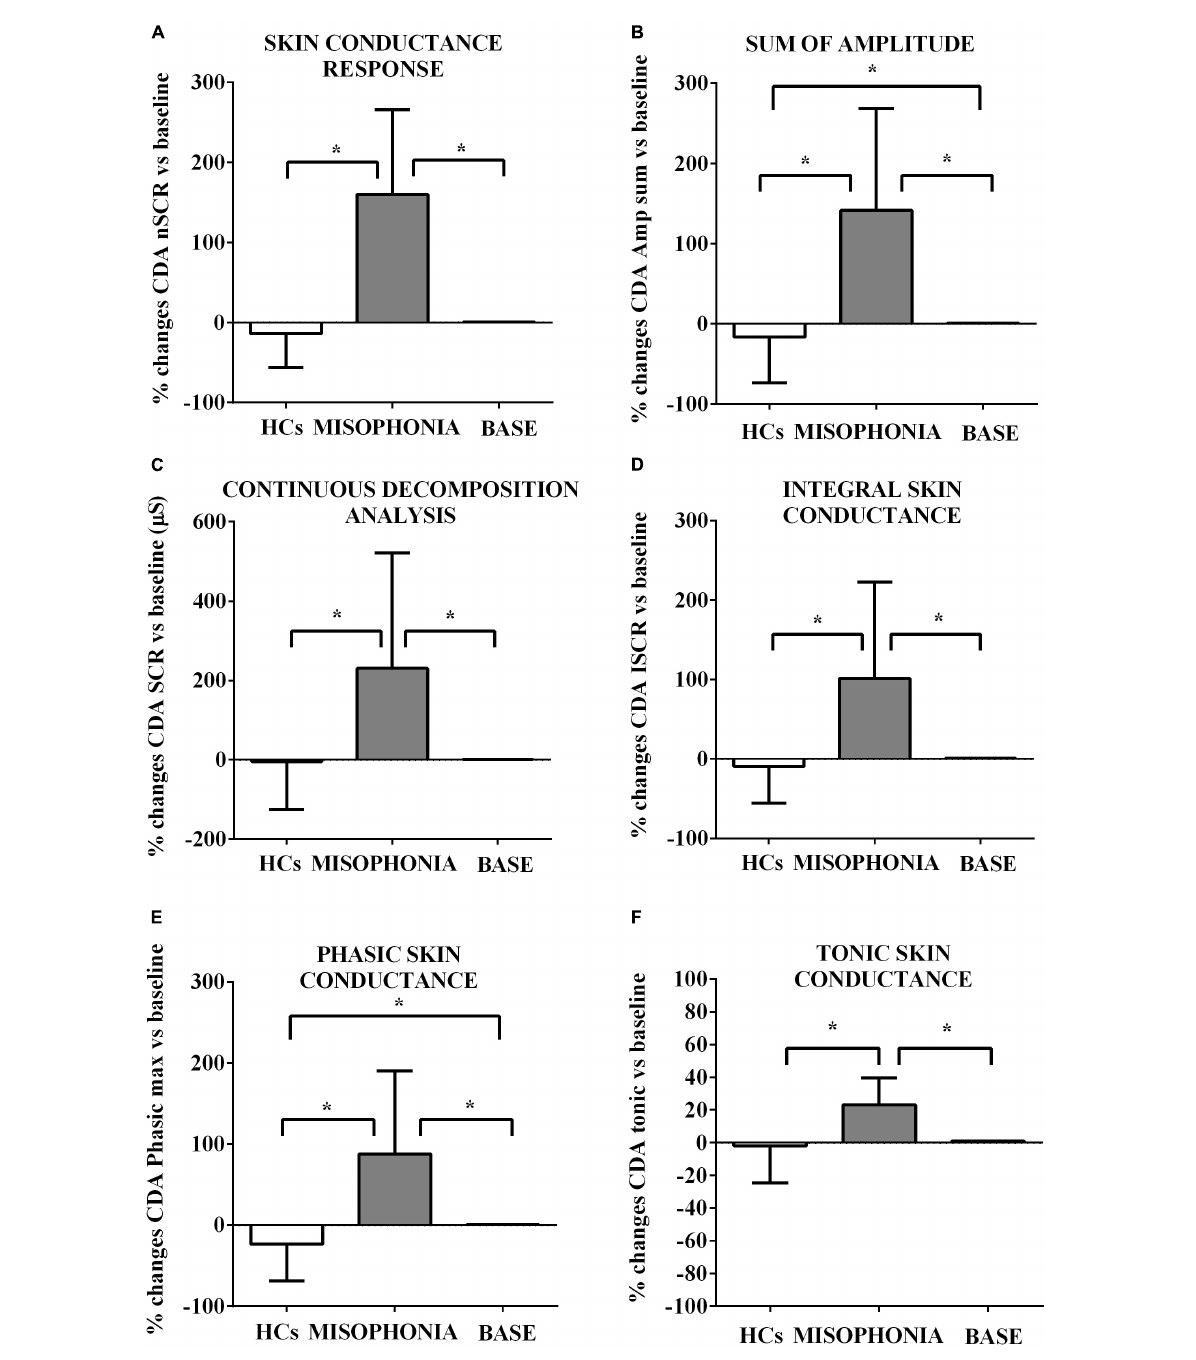
FIGURE4 Effects of the trigger sounds protocol on GSC variables in participants with misophonia and participants without misophonia [Healthy controls (HCs)] vs. specific baseline (set as 1). The results show increased orthosympathetic variables (CDA.nSCR, CDA.AmpSum, CDA.SCR, CDA.iSCR, CDA.PhasicMax, and CDA.Tonic) in participants with misophonia in comparison with values registered at the baseline (set as 1). In participants without misophonia, some of those variables related to orthosympathetic activation (CDA.AmpSum and CDA.PhasicMax) were lower in comparison with values registered at the baseline. CDA, continuous decomposition analysis; SCR, skin conductance response; CDA.nSCR (A) , SCRs within response window (wrw); CDA.AmpSum (B) , sum of SCR-amplitudes of significant SCRs; CDA.SCR (C) , continuous decomposition analysis skin conductance response; CDA.iSCR (D) , integral of SCR over the 10-s non-overlapping time; CDA.PhasixMax (E) , maximum value of phasic activity wrw; CDA.Tonic (F) , the mean tonic activity wrw. The results are the mean ± SE. The parentheses indicate significance between groups, as specified in Figure 2F . Various groups are represented as in Figure 2 . The statistical analysis between M and HCs was performed through the Mann–Whitney test, whereas the statistical analysis between M/HCs and baseline was performed through the Wilcoxon